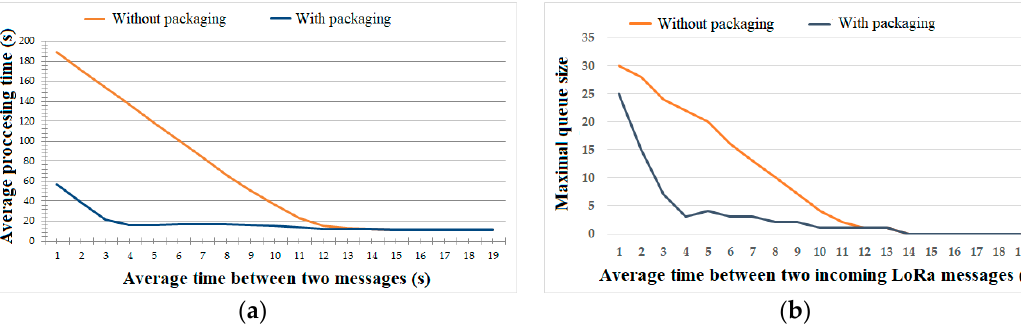
Figure 7. Satellite network performance as a function of inter-arrival time of LoRa messages: ( a ) average message processing time (s); ( b ) maximal queue size.